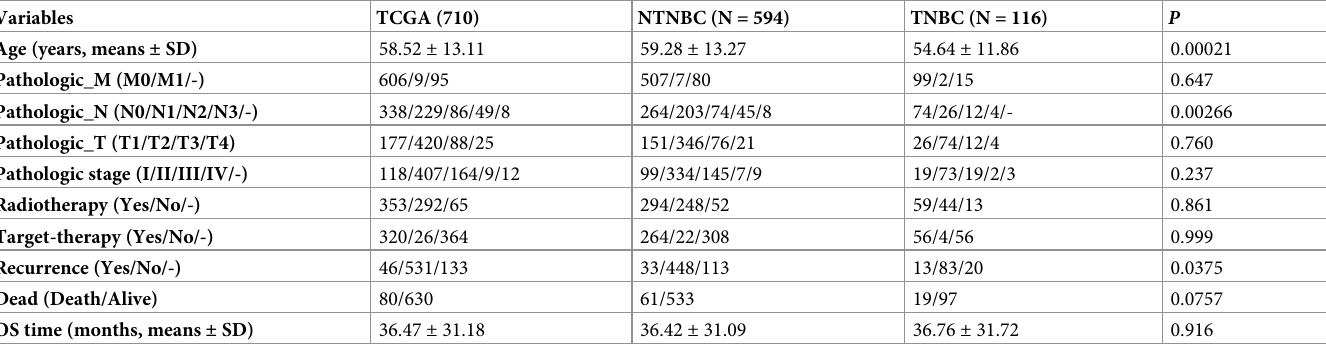
Table 1. The clinical prognosis information statistics of breast cancer samples in the TCGA database.